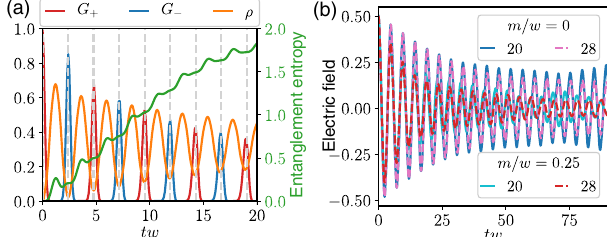
FIG. 3. Characterization of slow dynamics in the FSS model. (a) Hilbert space characterization of the persistent string inver- sions ( m ¼ 0 , L ¼ 28 ): alternating strong revivals of the overlaps ˆ Ht G ð t Þ ¼ jh 0 j e − i j 0 ij 2 with the two bare vacuum states j 0 i , (cid:3) (cid:3) þ (cid:3) corresponding to the two charge-density wave configurations of Rydberg atom arrays. Both the total density ρ ¼ h ˆ ρ j i of particle- ˆ Φ † ˆ Φ 1 − ð − 1 Þ j (cid:2) = 2 , and the antiparticle pairs, with ˆ ρ j ¼ ð − 1 Þ j j þ ½ j half-chain entanglement entropy (see the Appendix A) have regularly spaced maxima between the peaks. (b) Persistent oscillations of electric field for two values of the mass and of the system